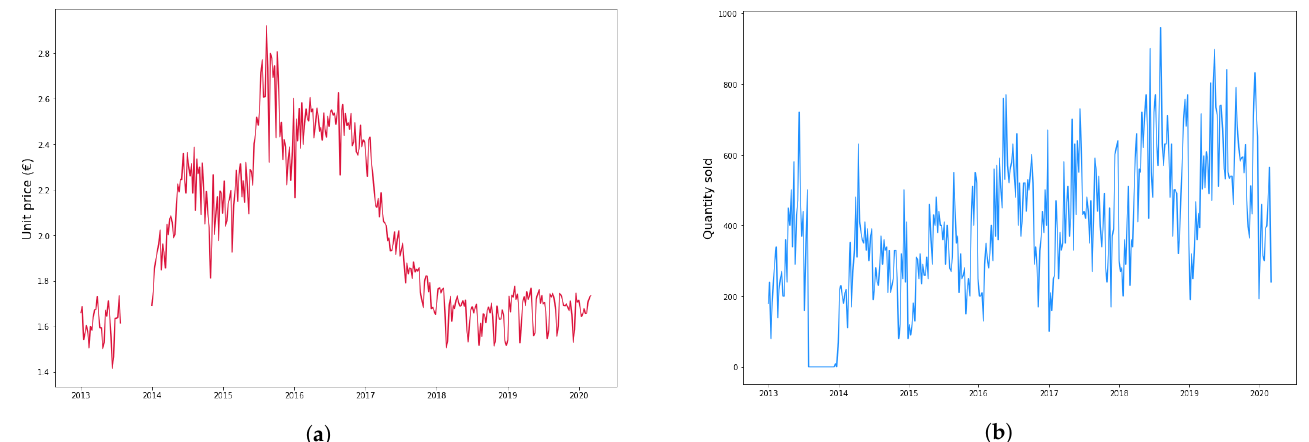
Figure 2. ( a ) Unit price and ( b ) sold quantity time series for product 1 after resampling with weekly frequency.